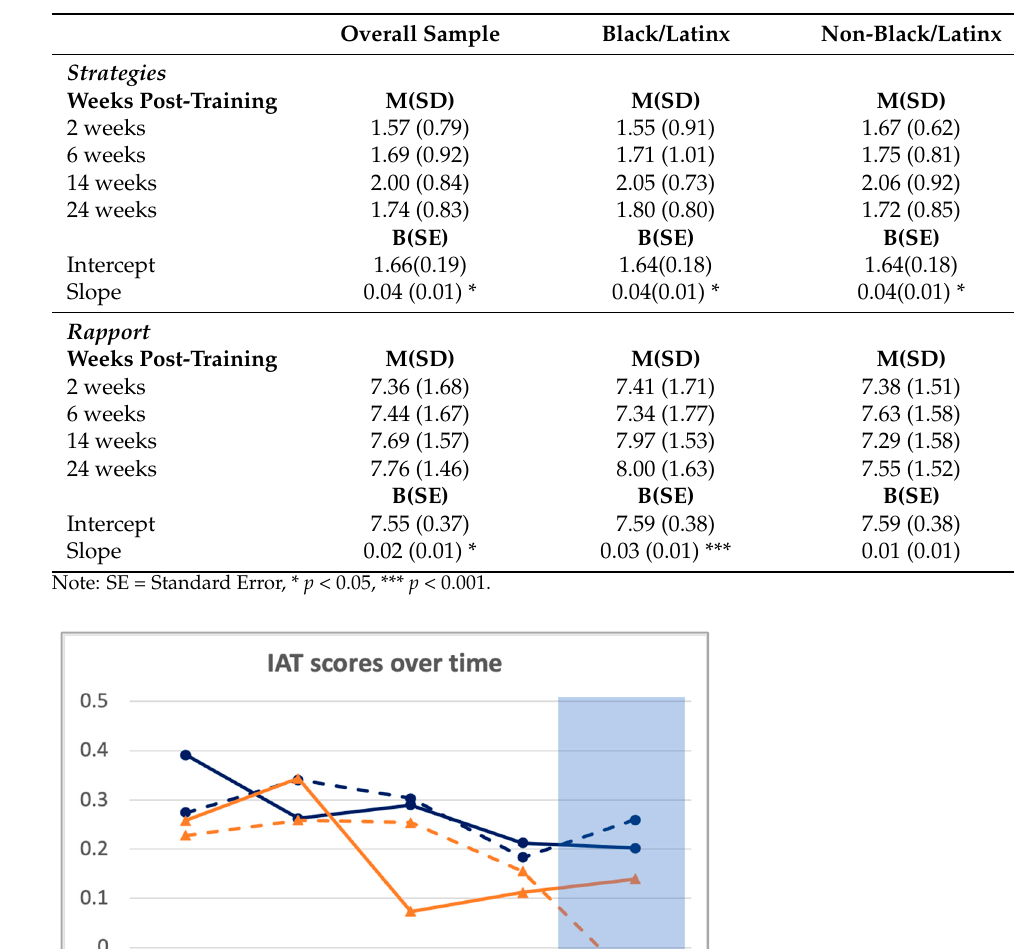
Table 2. Clinician-Reported VIBRANT Strategies and Rapport by Race/Ethnicity.